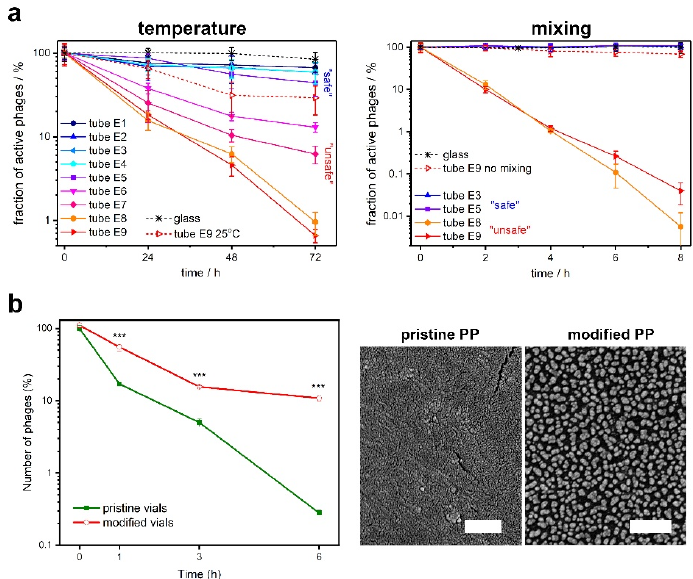
Figure 2. The absorption of bacteriophages on plastic surfaces. ( a ) A comparison of absorption of phages on different types of plastic surfaces enhanced by temperature and mixing [95]. ( b ) The re ‐ duction in phage absorption on polypropylene vial surface upon covering with gold ‐ polyoxoborates nanocomposite (*** p < 0.001) [97]. Panels were adapted from Richter et al. [95], and Wdowiak et al. [97], based on the CC BY 4.0